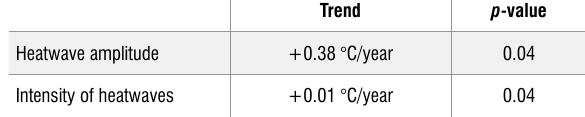
Heatwave trends for the period 1950–2016 in northernmost Limpopo Province Trend p -value Heatwave amplitude +0.38 °C/year Intensity of heatwaves